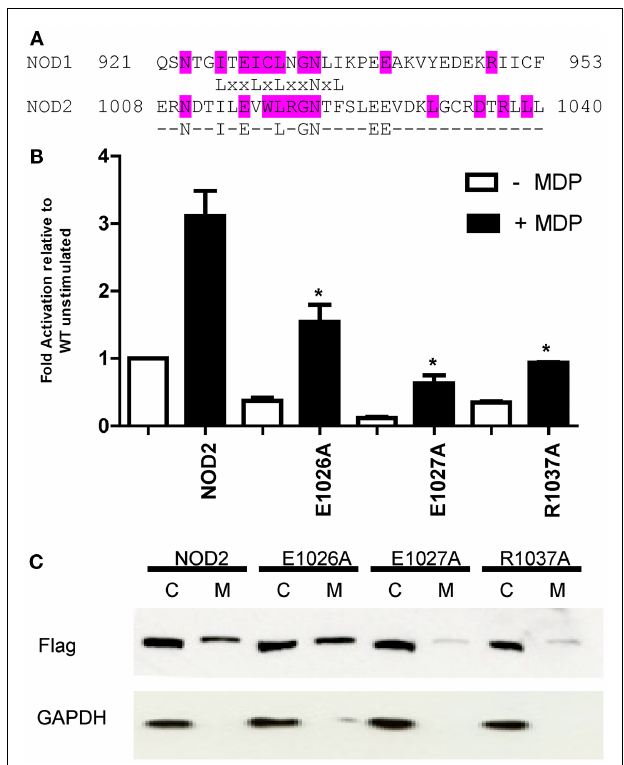
FIGURE 7 |The impact of mutation of conserved residues between the C-terminus of human NOD1 and NOD2 on receptor function . (A) Alignment of the terminal 33 amino acids of human NOD1 and NOD2. Residues highlighted in cyan are conserved across mammals in the relevant protein.The consensus sequence highlights residues found in the termini of both human NOD1 and NOD2. (B) NF κ B luciferase reporter assays were performed in HEK293 cells using wild-type pCMV-NOD2 and the point mutants E1026A, E1027A, and R1037A. DNA (0.1ng/well) was transfected into 96-well plates with (black bars) and without (white bars) muramyl dipeptide (MDP). After 24h cells were lysed and NF κ B activity determined. Results show the average of three independent experiments and * p < 0.05. Error bars indicate SEM. (C) Subcellular fractionation was performed with wild-type and mutant NOD2 constructs to separate the cytoplasmic (C) and membrane-bound (M) fractions. Proteins were identified with the specified antibodies. Blots are representative of three independent